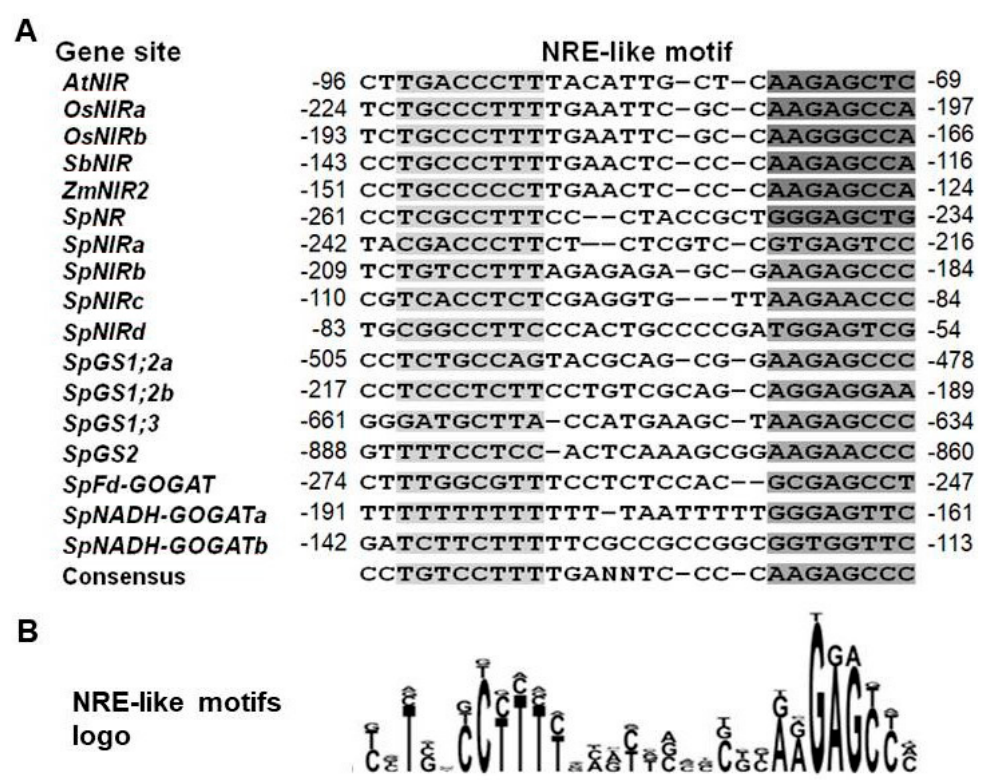
Figure 6. NRE ‐ like sequences in promoters of S. polyrhiza N assimilation genes aligned with corre ‐ sponding motifs in other plants. ( A ) Alignments of the NRE ‐ like sequences identified in promoters of: AtNiR (AT2G15620, Arabidopsis thaliana ); OsNiR (two motifs: OsNiRa and OsNiRb , LOC4326014, Oryza sativa ); SbNiR (LOC8075200, Sorghum bicolor ); ZmNiR2 (LOC542264, Zea mays ). Promoter se ‐ quences of the SpNR , SpNiR , SpGS1;2 , SpGS1;3 , SpGS2 , SpFd ‐ GOGAT , and SpNADH ‐ GOGAT genes are from the genome of S. polyrhiza ecotype Sp9509, available in online databases (NCBI taxid: 29656; GCA_900492545.1). Numbers in front and at the end of the nucleotide motifs indicate their position relative to the gene translation start site. ( B ) The NRE ‐ like motif logo displays the consensus se ‐ quences generated by CLC Main Workbench 7.6.1.